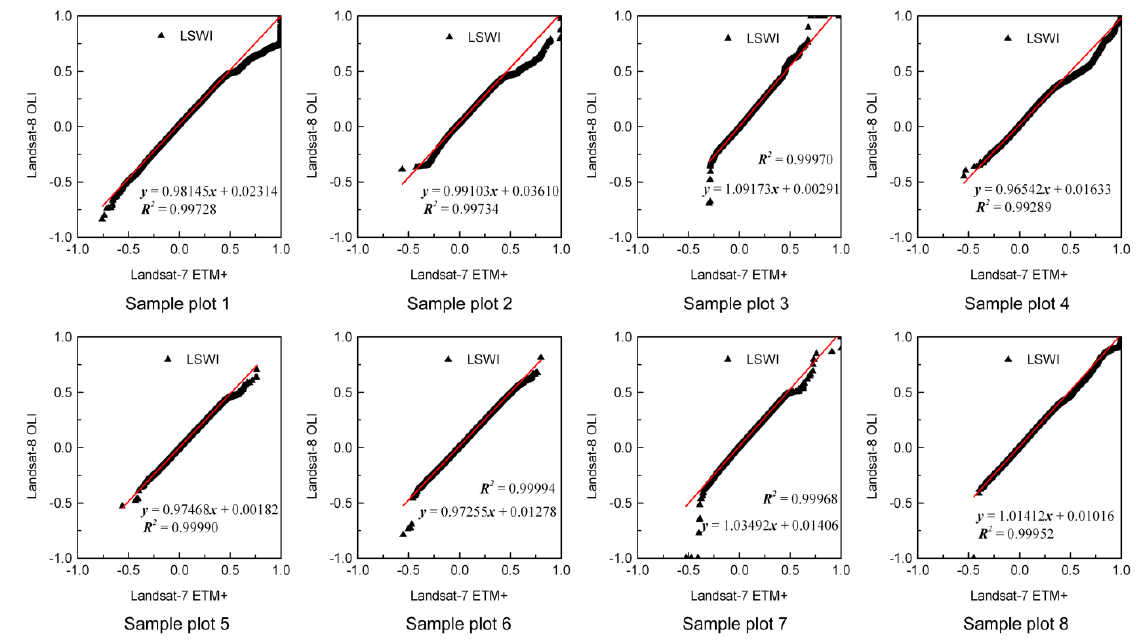
Figure 9. Statistical relationship between Landsat-7 ETM+ and Landsat-8 OLI LSWI values for the eight sample plots. The linear regression equation and R 2 value are given in each plot. The red solid line refers to the linear fitting